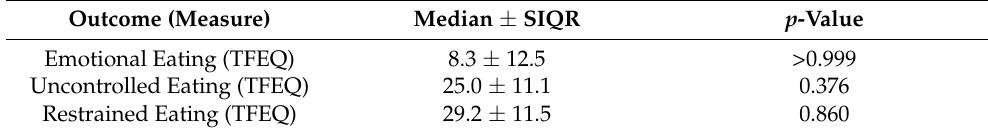
Table 2. Median scores by TFEQ